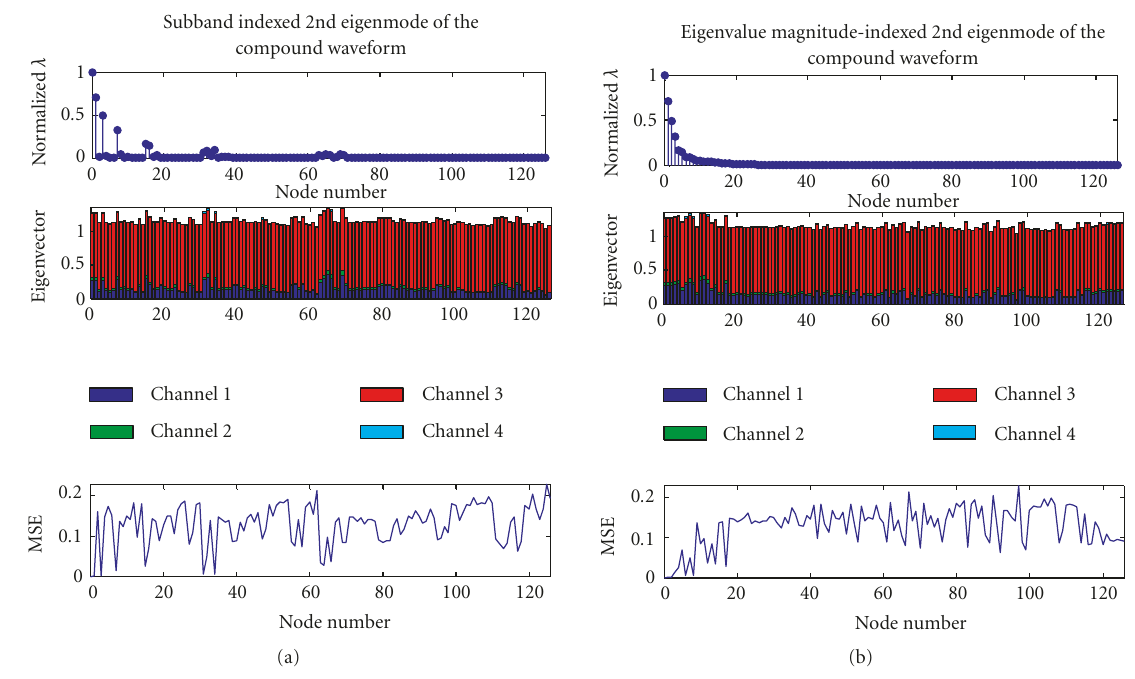
Figure 10: (a) 2nd eigenmode of the compound waveform in Figure 9(c). (b) Same data in (a) arranged in descending order of magnitude j of λ 2